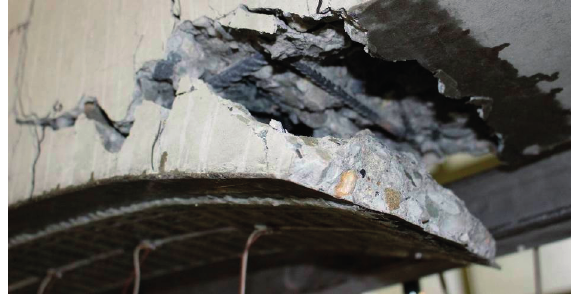
Figure 13. Failure of the RC beam strengthened with textile